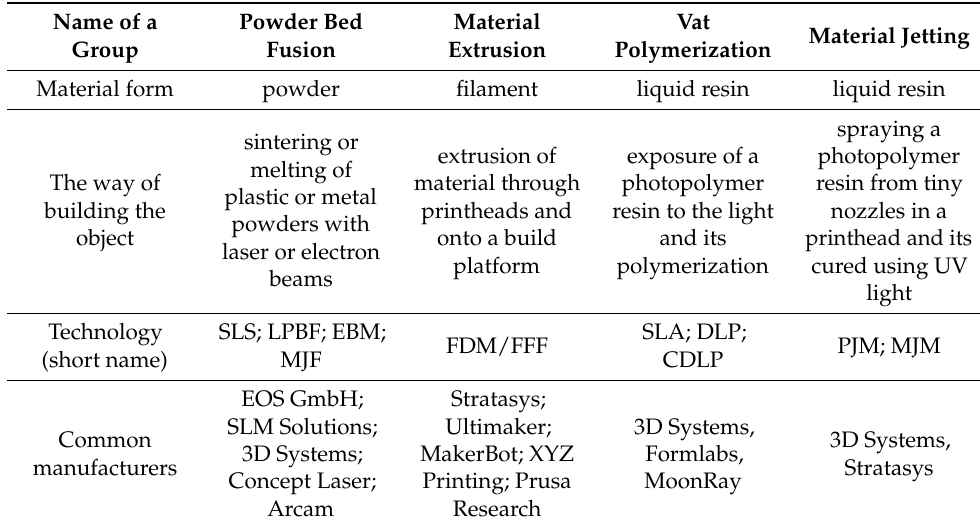
Table 1. An overview of various AM